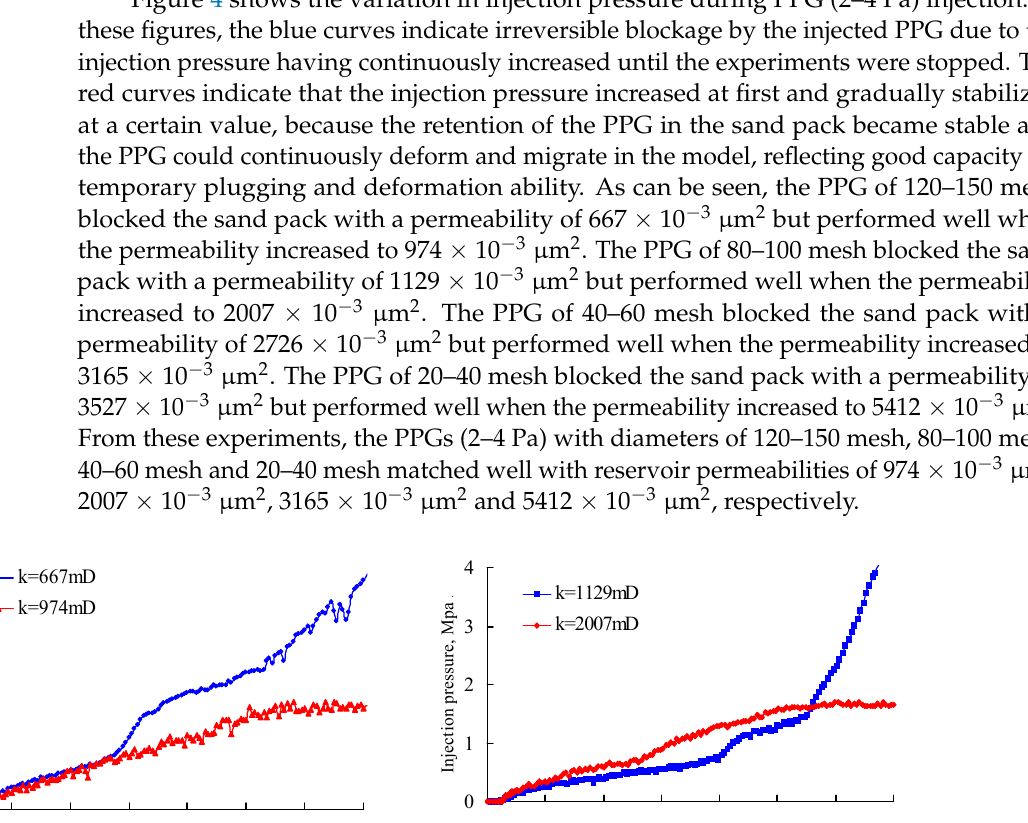
5 of 11 The key procedures of the glass-etched-model oil displacement experiment are listed as follows: (1) Clean and vacuumize the glass etching model. (2) Saturate the model with simulated formation water, and measure its porosity and permeability. (3) Saturate the